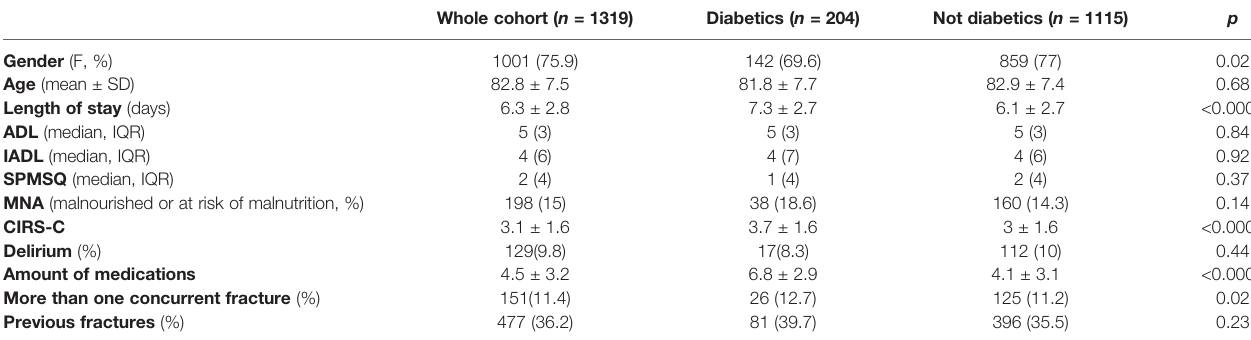
TABLE 1 | Clinical and demographic characteristics of diabetic and non-diabetic patients with hip fracture hospitalized in our orthogeriatric ward. Whole cohort ( n = 1319) Diabetics ( n = 204) Not diabetics ( n =